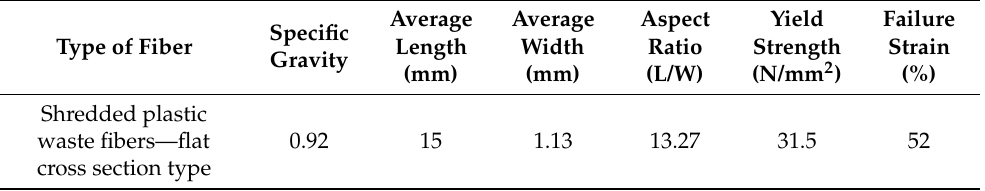
Table 2. Properties of the plastic fibers used in this study.